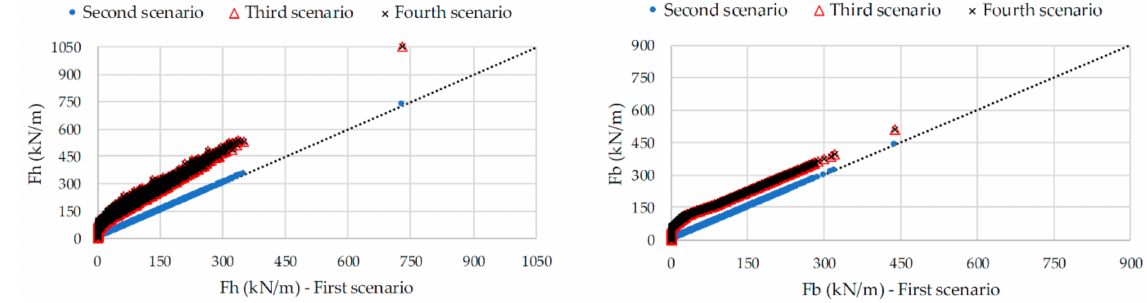
Figure 16. Horizontal and vertical forces for the first scenario compared with the second to fourth scenarios— Pedersen et al. (1996).